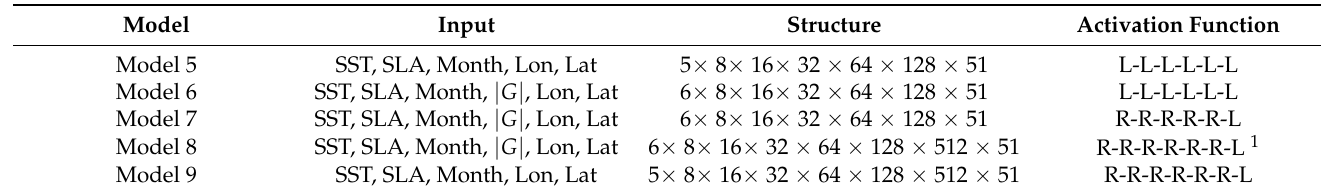
Table 2. Reconstruction model details for experiments on improving the performance of upper ocean temperature estimations.